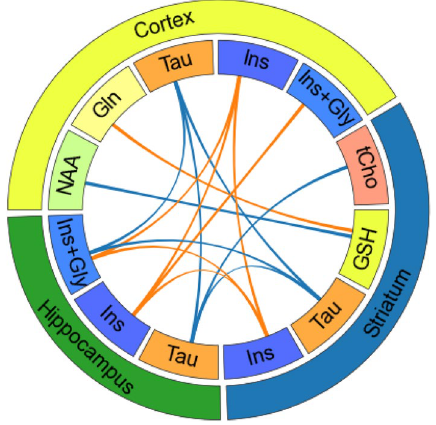
Figure 5. Inter-regional correlations. Correlation between metabolite concentrations in different brain regions. Lines represent highly significant correlations ( p < 0.001). Blue, correlations in WT rats; orange, correlations in TgF344-AD rats. Intra-regional correlations between displayed metabolites, shown in Fig. 4, are not plotted